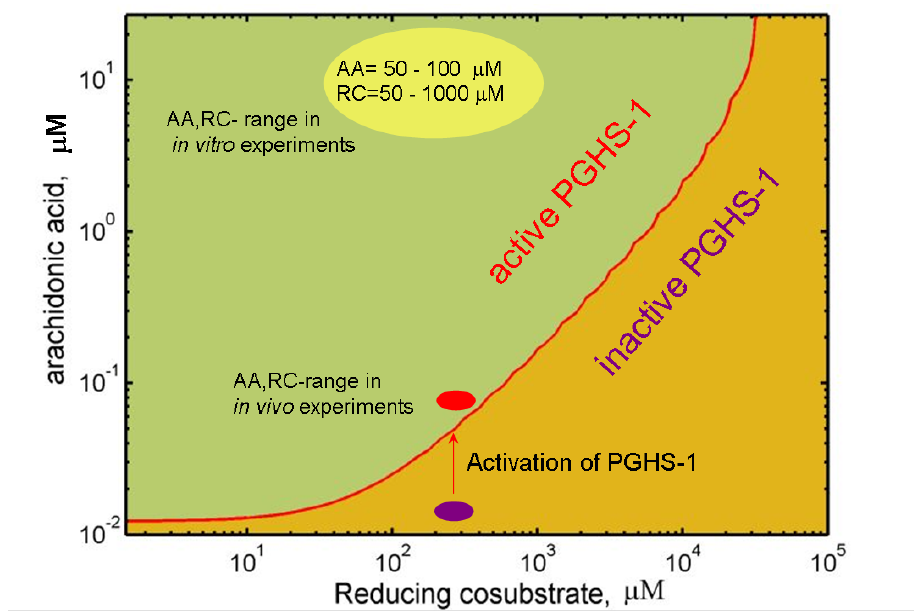
Figure 2. Working region of PGHS-1 depending on concentrations of arachidonic acid, AA and reducing cosubstrate, RC